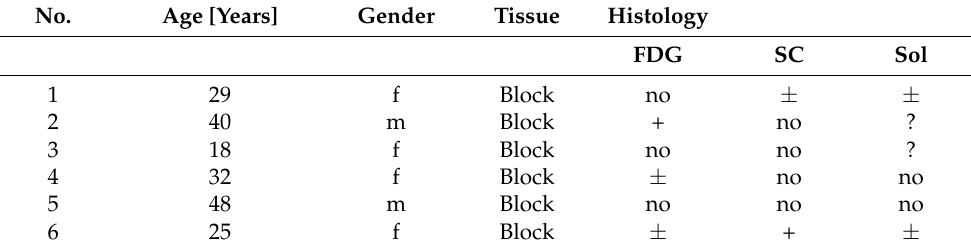
Table 2. Demographic data of WD gallbladder tissue (C-GB). Age [years] at the time of chirurgical removal of liver and gallbladder. FDG: signs of fatty degeneration, SC: signs of cholestasis and SoI: signs of